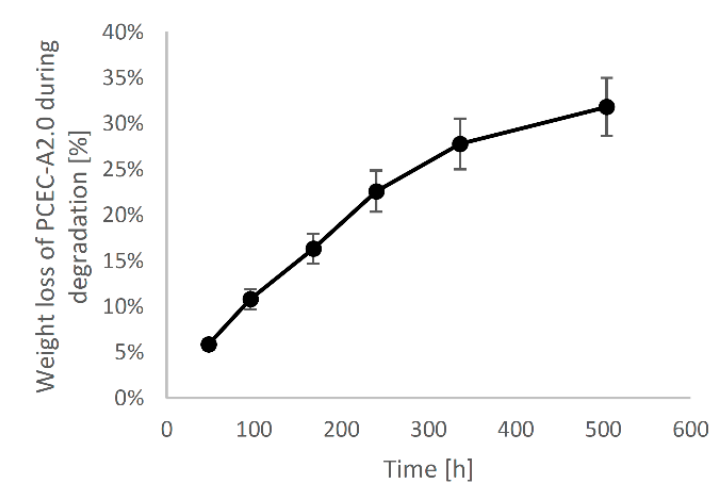
Figure 11. Hydrolytic degradation of PCEC-A2.0 hydrogel (20 wt%).